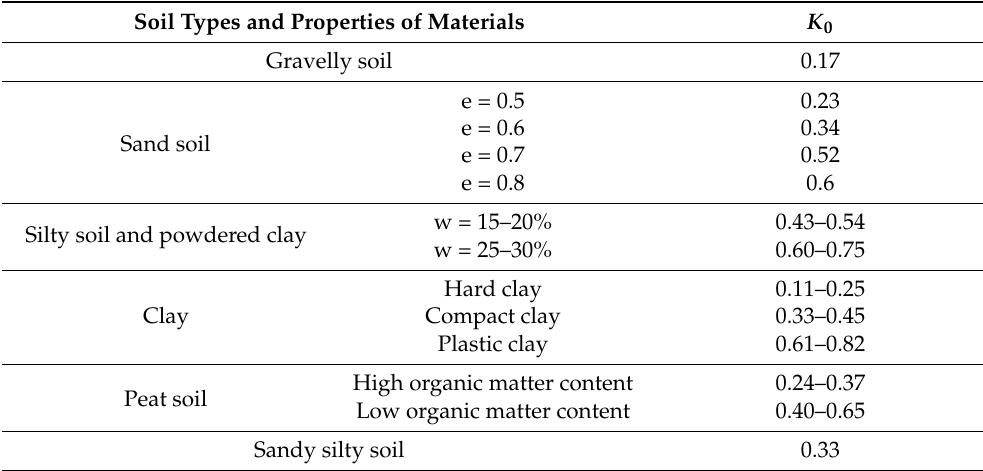
Table 1. Static earth pressure coefficient K 0